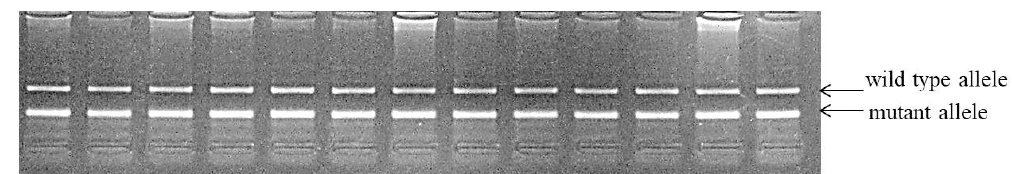
Figure 2. The fragment of the genotyping of the Belgian Blue population for the M1 genetic